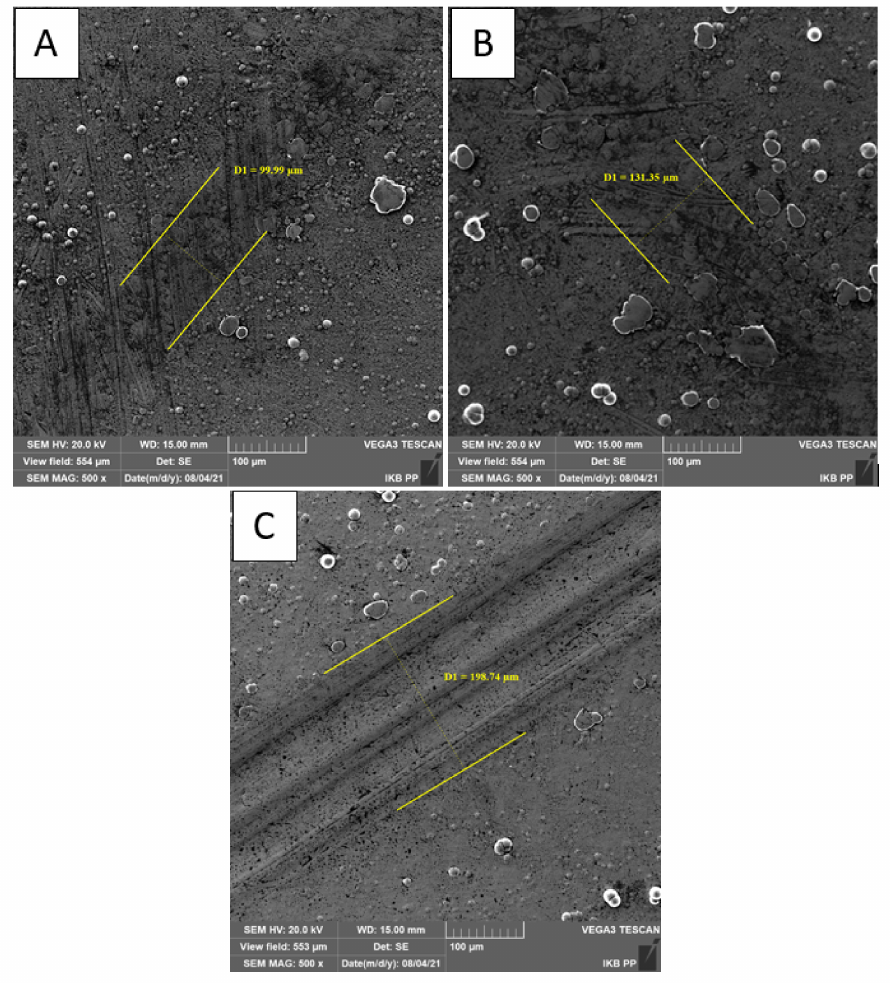
Figure 9. SEM Images of cracks for samples with NiP/Si 3 N 4 coatings deposited in a bath with